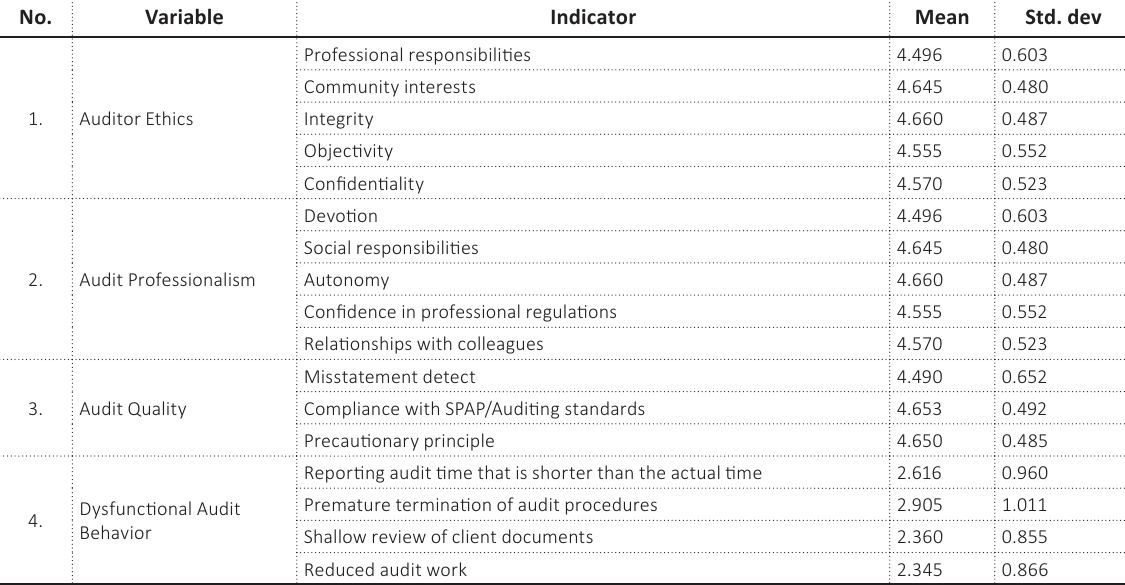
Source: WarpPLS data processing